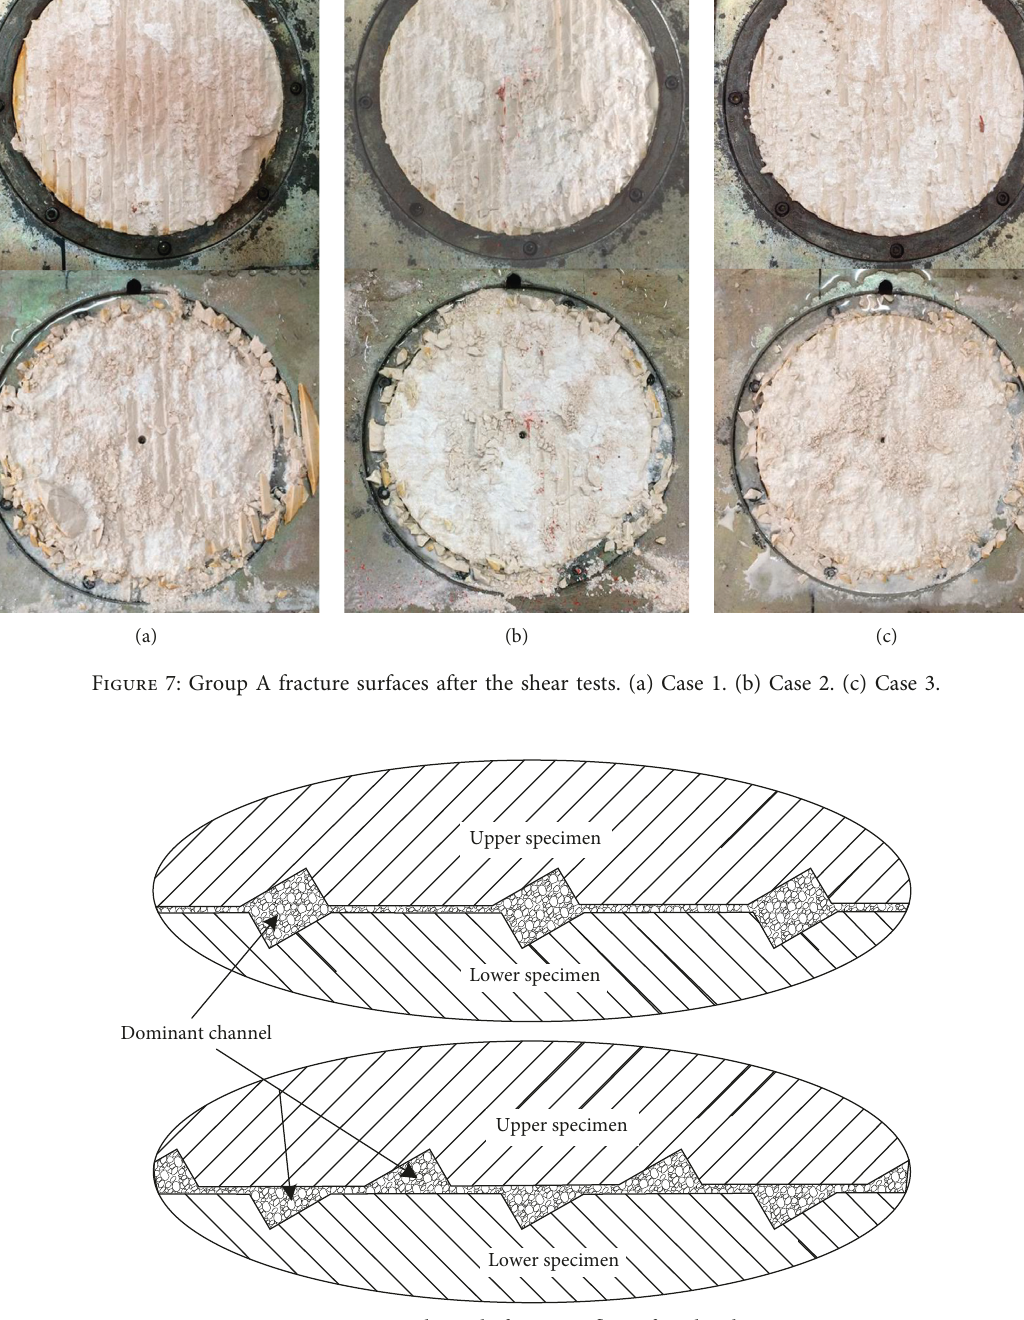
Figure 8: Dominant channels for water flow after the shear surface of the other three groups is relatively complete. Group B: as shown in Figures 6(b) and 9, under the The fissure width of combination III increases dra- action of gouge and flow disturbance, an increase in matically during shear, and the final value is much shear velocity makes the upper and lower surfaces slide more easily. The fissure width decreases with an in- crease in the shearing velocity of the fracture surface. Group C: Figure 10 shows that after the shear test, width. except for combination III, evolution of the fracture